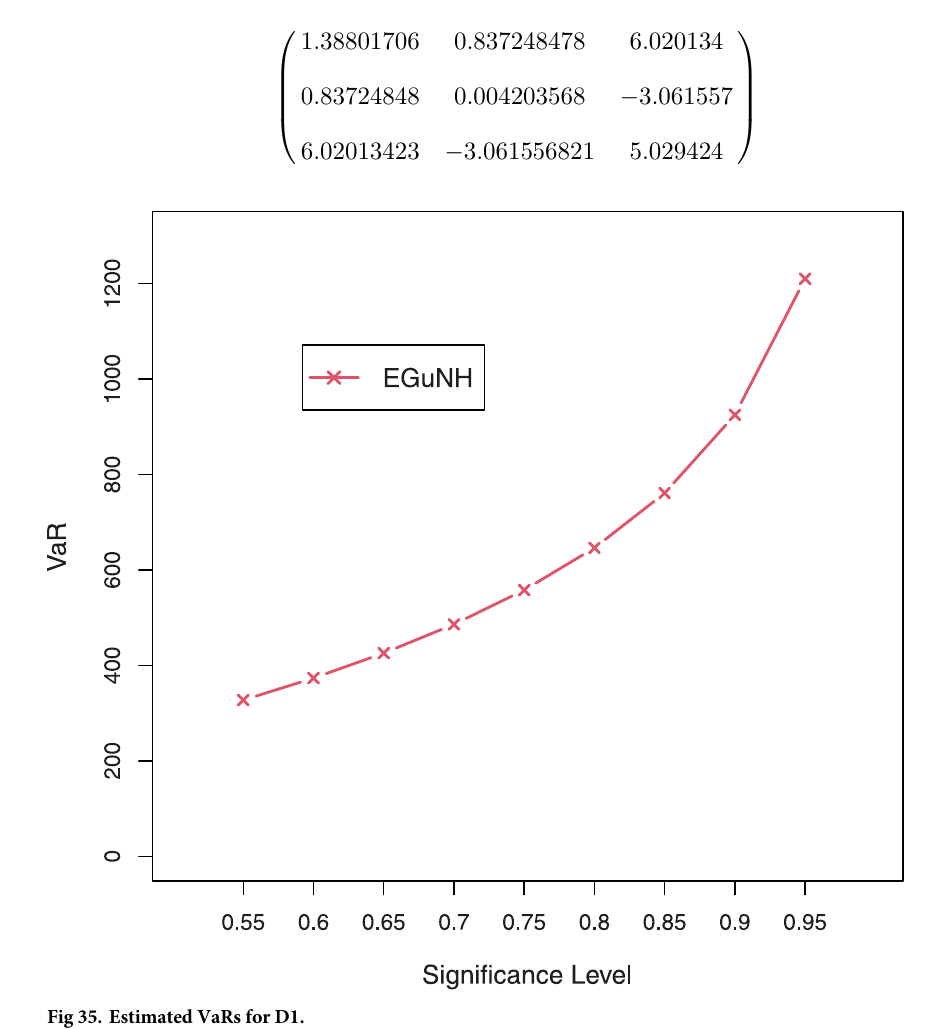
Fig 35. Estimated VaRs for